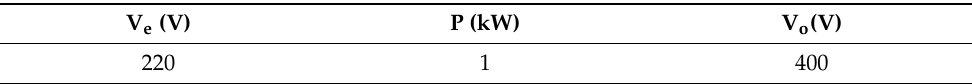
Table 1. System specification.